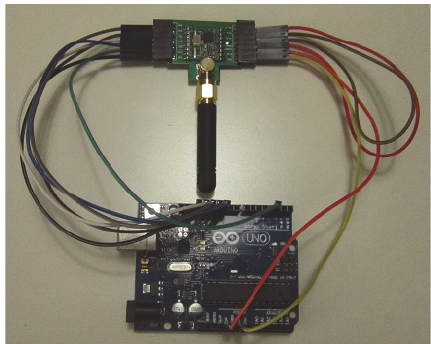
Figure 6: Real-time implementation of tag configuration.